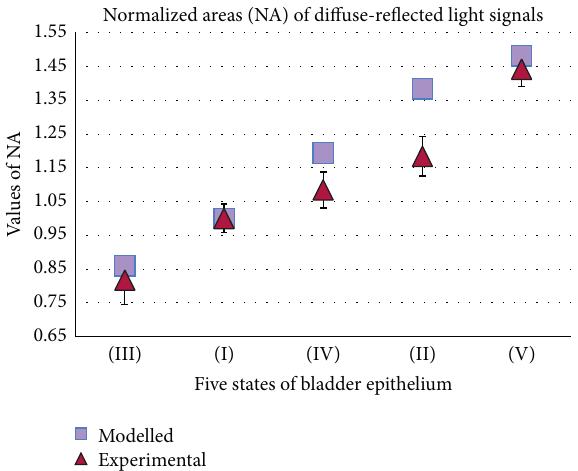
Figure 2: Comparison of experimental (average values) and simu- lation diffuse-reflected light area ratios for 5 states of bladder epithe- lium: (I) normal, with normal size of cell nuclei, (II) enlarged nuclei, (III) absorption growth, (IV) population density augmentation, and (V) all the changes